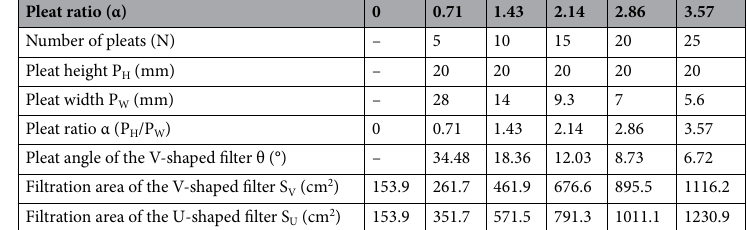
Table 1. Parameters of the self-made pleated